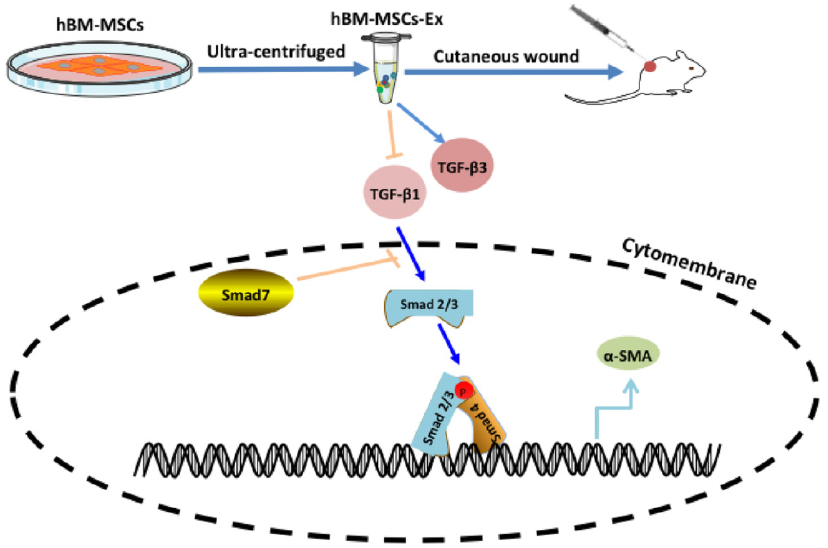
Figure 8. Schematically ilustration of hBM-MSC-Ex stimulates cutaneous wound healing by regulating the TGF- β /Smad signal pathway [138]